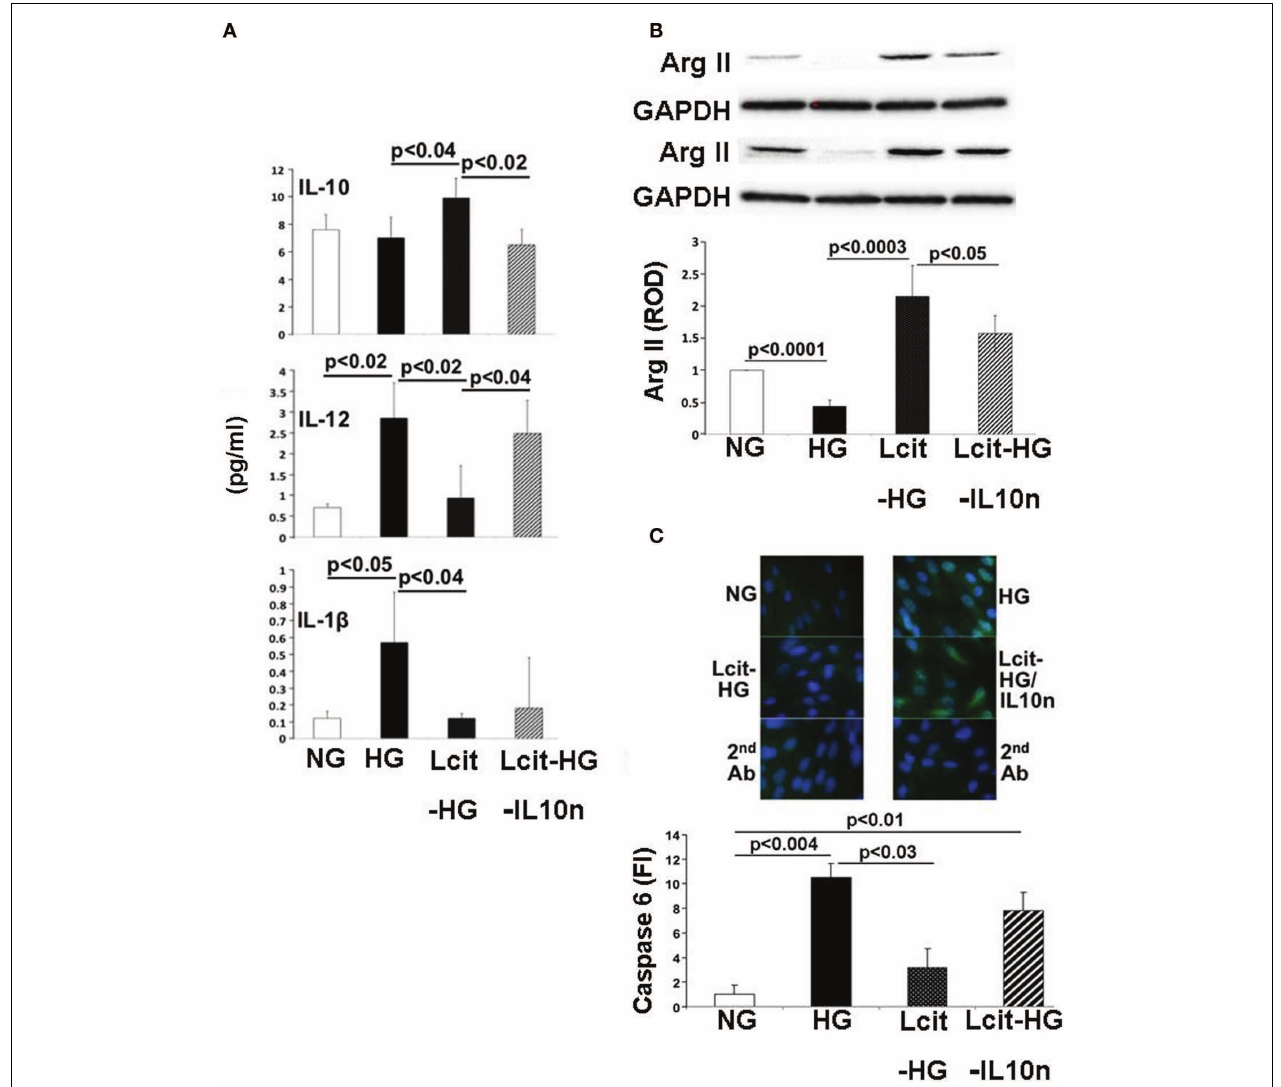
treatment with HG.This effect was markedly reduced by concurrent L -cit treatment, while addition of anti-IL-10 antibody (IL10n) along with L -cit partially prevented L -cit-induced elevation of arginase II. (C) huPTEC were seeded onto slide chambers. After completion of treatments, cells were immunostained using caspase 6 as primary antibody, followed by Cy5-conjugated goat anti-rabbit secondary antibody. DAPI was used for nuclear staining. Representative images (upper) and microscopy analysis of nuclear fluorescence intensity (lower) show an increase nuclear localization of caspase 6 (green fluorescence) following treatment with HG.This effect was markedly reduced by concurrent L -cit treatment, while the effect was abolished by addition of neutralizing anti-IL-10 antibody (IL10n) along with L